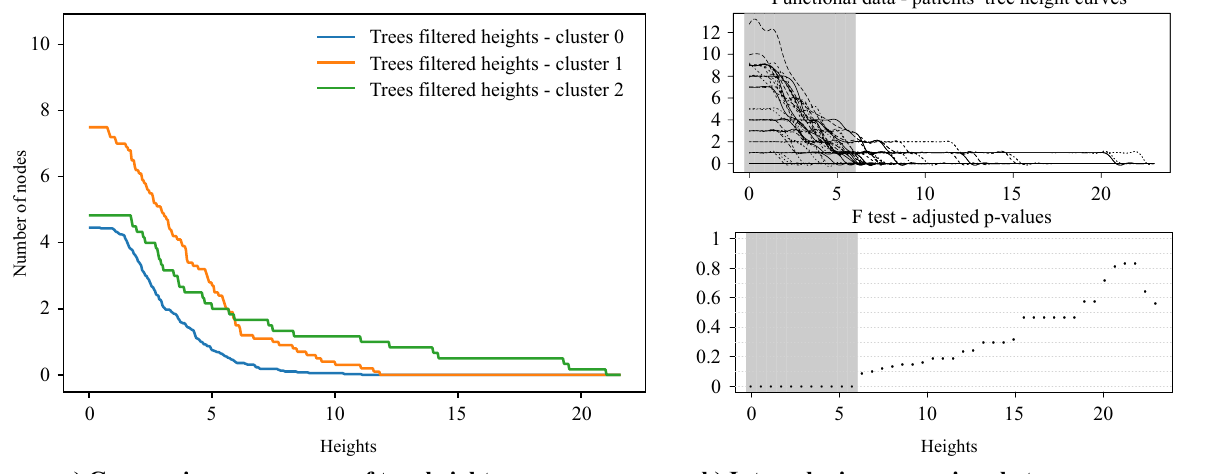
Figure 2. ( a ) Curves displaying the filtered heights of the trees’ vertices for the three groups. Operationally, curves were built as follows: for any fixed height (x-axis), for any tree in the selected group, we count the number of nodes whose height value is greater than the fixed one (y-axis). For the step-by-step procedure see Section 3 of Supplementary Materials online. The curves in the plot represent the pointwise within-group means of such counts, and the shaded regions cover an area of 1 standard deviation around the means. The values of such counting process result in a monotonically non-increasing function detecting information about trees’ heterogeneity. In fact, higher values of such function, especially as the height threshold becomes bigger and bigger, correspond to a greater number of heterogeneous lesions in the patients. Patients of group 0 (blue line) are characterized by a very homogeneous disease where trees branches are on average less and very short compared to the other groups; patients of group 1 (orange line) tend to exhibit more lesions than patients belonging to group 0, lesions which are intermediately heterogeneous, as their representation trees display both short branches and longer branches than group 0; patients in group 2 (green line) are associated to very heterogeneous diseases, displaying a similar number of lesions to group 0, but with the associated branches being much longer. A synthetic example of tree per each group is displayed in Fig. 7, elucidating the differences with a graphical support. ( b ) Functional comparison between curves: in order to test the hypothesis that curves belonging to different groups are different, we use the ANOVA procedure proposed in 22 . It outputs an interval- wise adjusted p-value function. Depending on the sort and level α of Type-I error control, significant intervals can be selected. Here, we highlighted in grey the region of significance. Of note, the curves appear different for what homogeneity-heterogeneity balance is concerned; they lose significance as they approach very big height